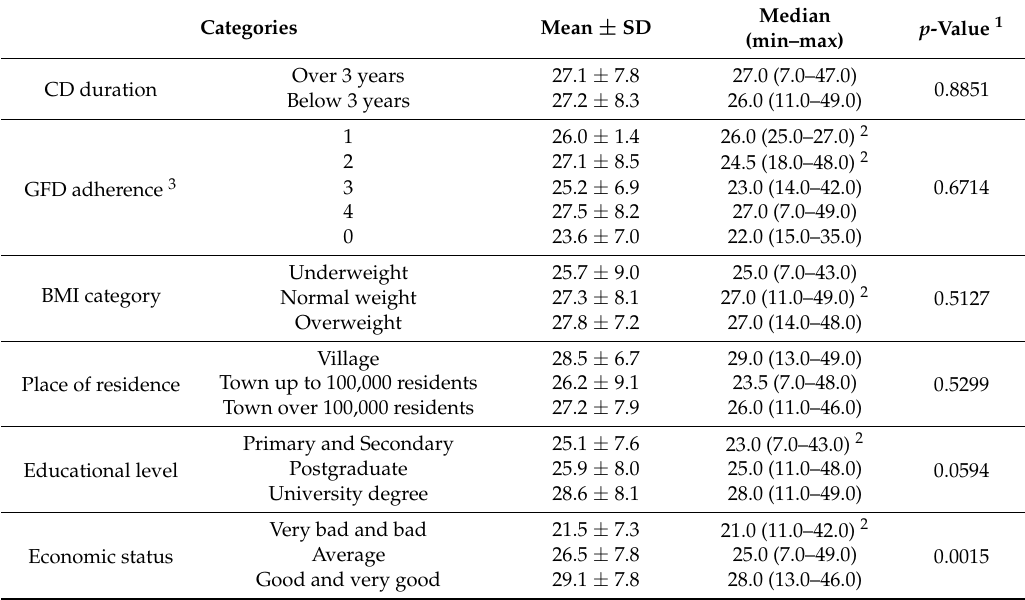
Emotional subscale data categorized by CD duration, GFD adherence, BMI and sociodemographic